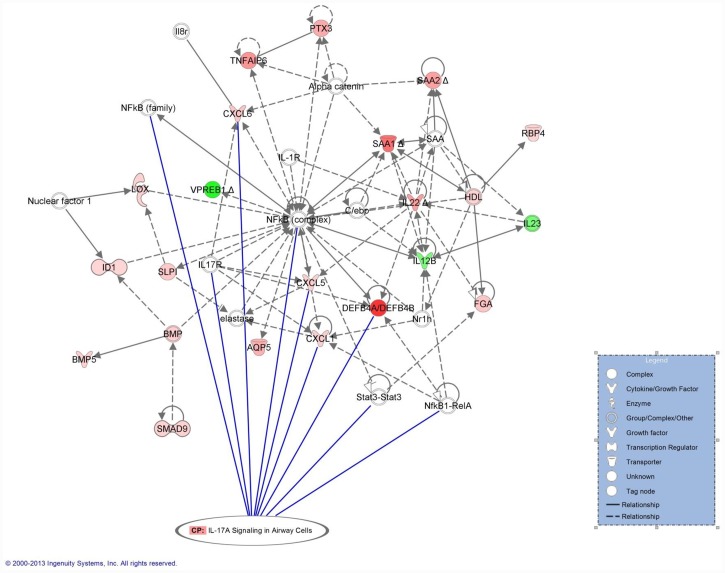
Relationship of the canonical IL-17 pathway to the NF-κB-based network.Following activation of its receptor, IL-17 promotes transcription of many pro-inflammatory genes including CXCL1, CXCL5, CXCL6 and beta-defensin, indicated by the solid lines. (The networks were generated through the use of QIAGEN’s Ingenuity Pathway Analysis (IPA QIAGEN Redwood City, www.qiagen.com/ingenuity).